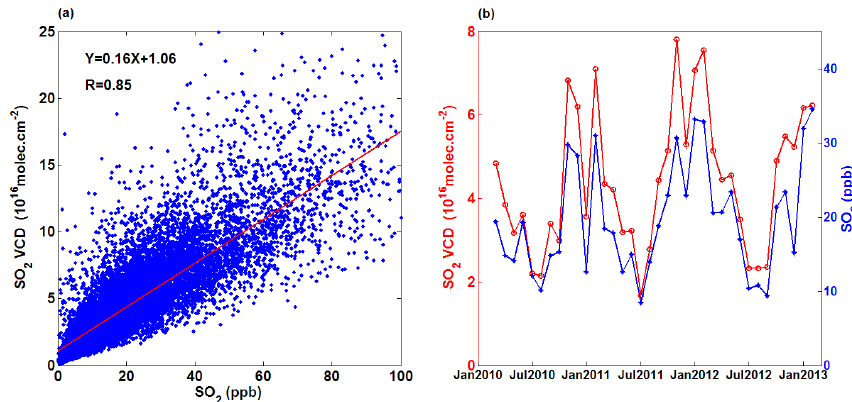
Figure 10. (a) Scatterplot of SO 2 VCD against surface concentration. The red line represents the linear least-squares fit to the data. (b) Tem- poral evolutions of monthly mean VCD and concentration from March 2010 to February 2013.